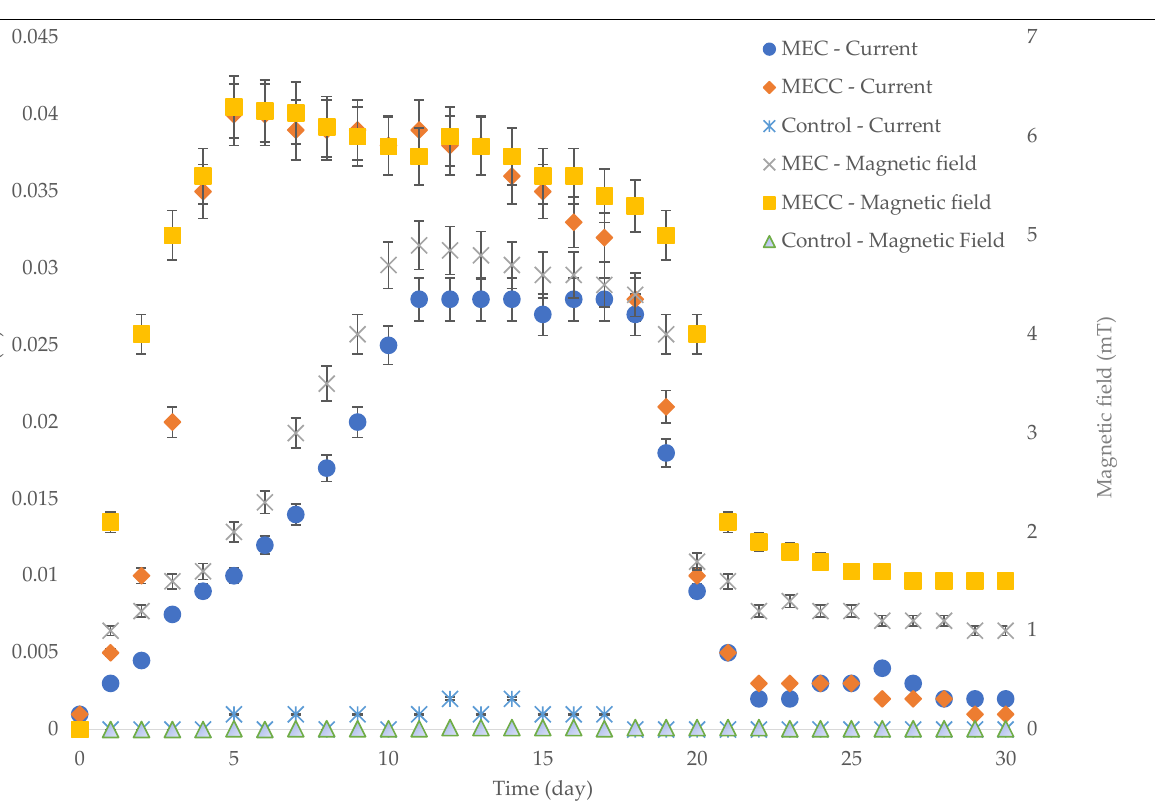
Figure 7. Effect of current on magnetic field.